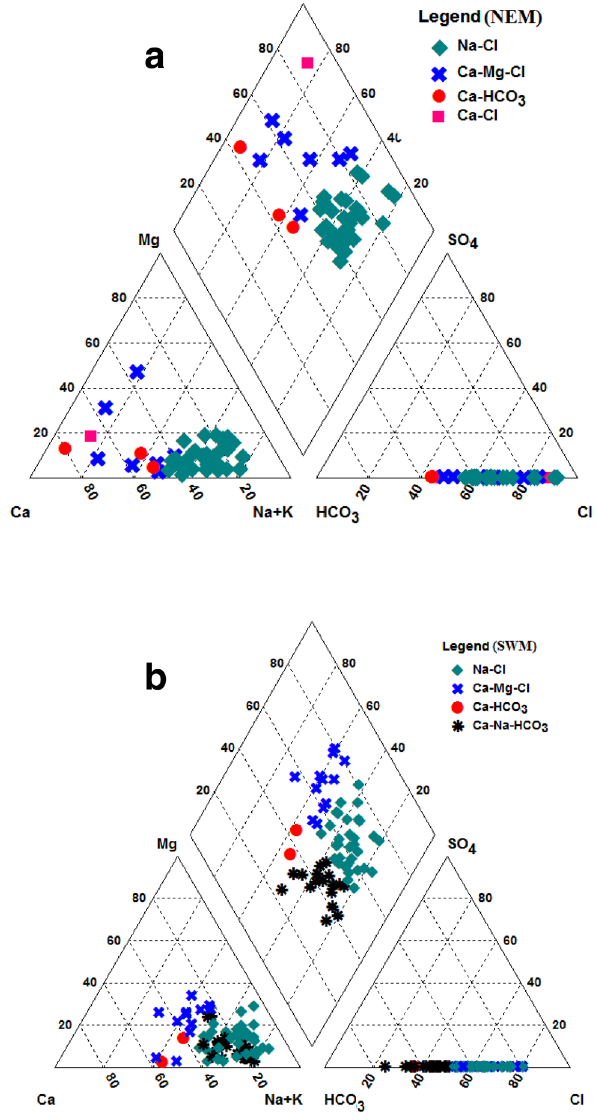
Fig. 8 a Major water types of the water samples during NEM are depicted in the Piper diagram. b Major water types of the